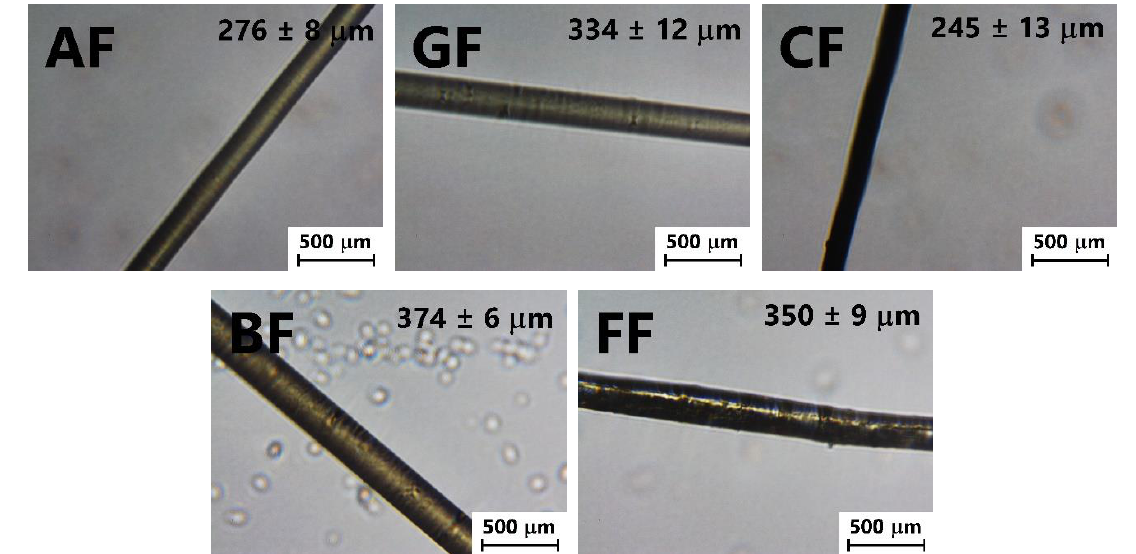
Figure 2. Microscopic images of single fibers used as reinforcement with a diameter measurement.